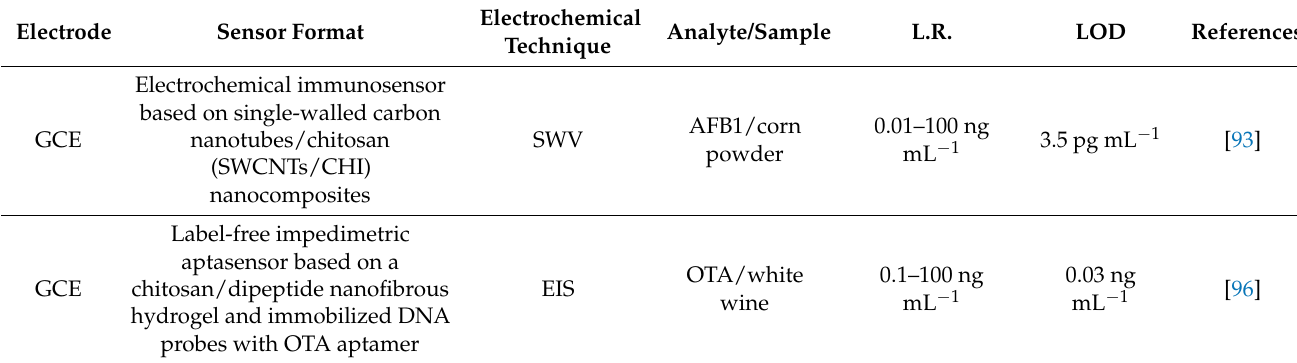
Table 4. Recent examples of CHI-based electrochemical sensors for toxins